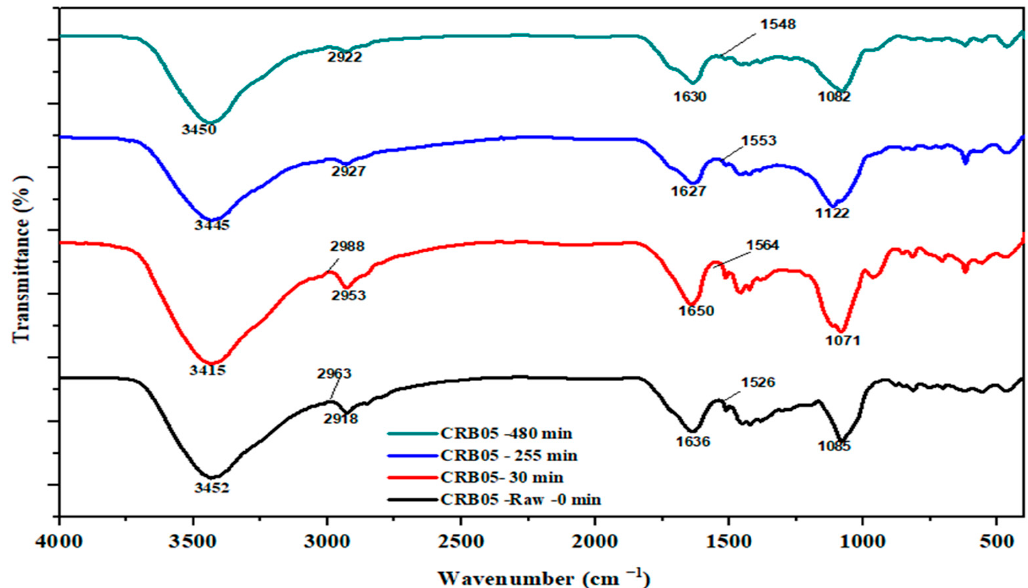
Figure 2. FTIR peaks for CRB05 before and after boron removal experiments.